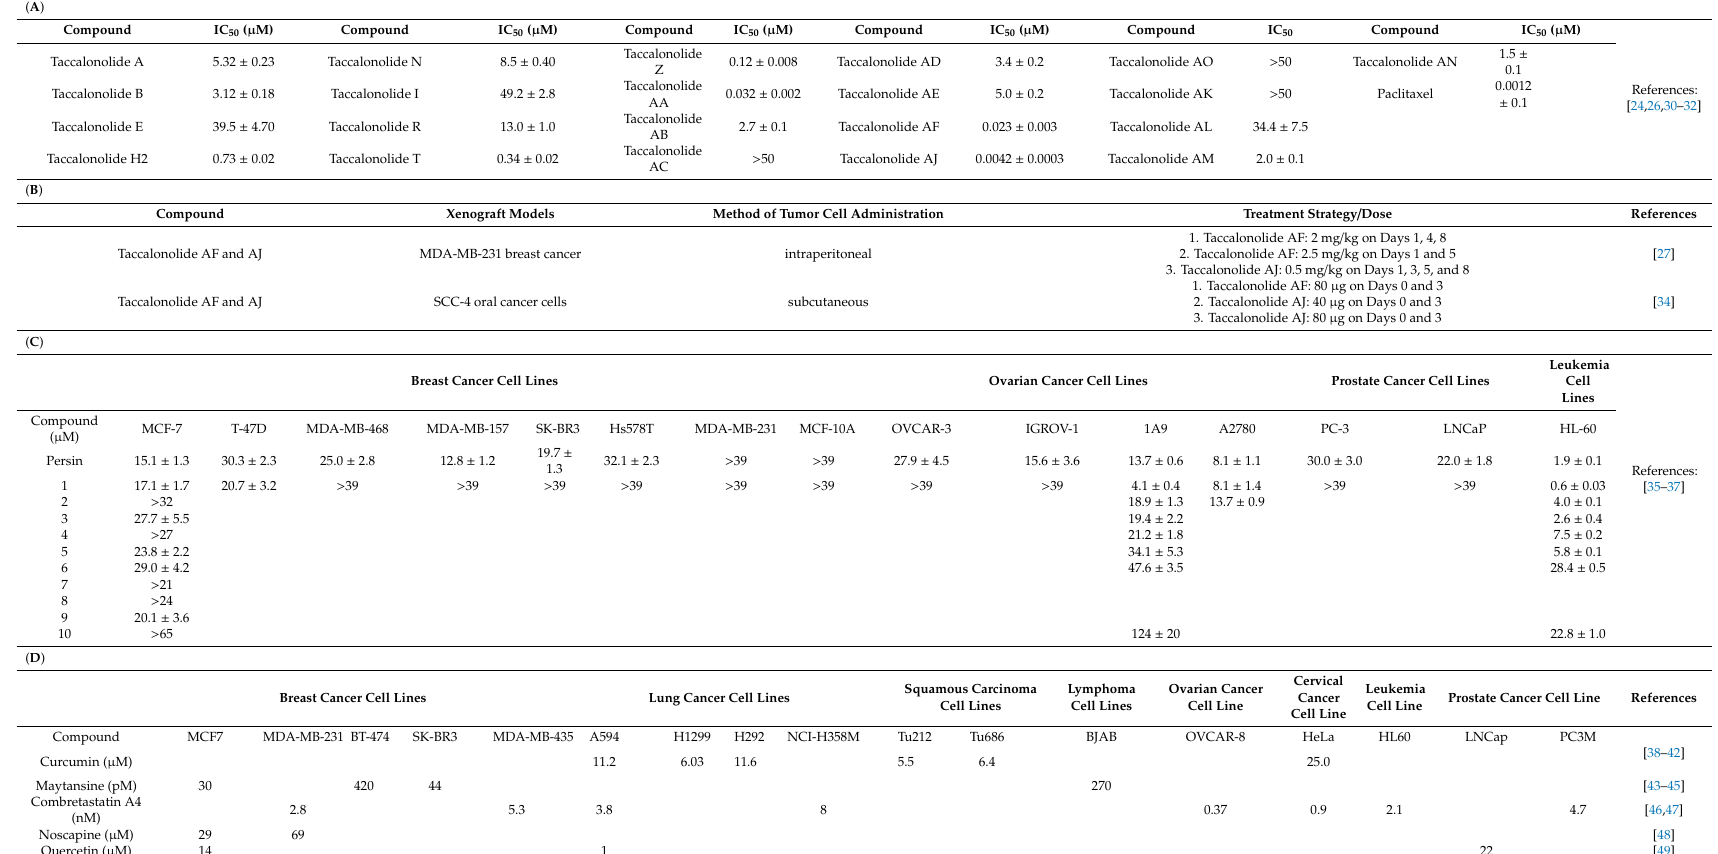
Table 1. ( A ) Half-maximal inhibitory concentrations (IC50) of taccalonolides in HeLa cells. ( B ) Details of in vivo tumor xenograft studies in mice using taccalonolides AF and AJ. IC50 of ( C ) persin and its analogues, and ( D ) curcumin, maytansine, combretastatin, noscapine, and quercetin in various cancer cell